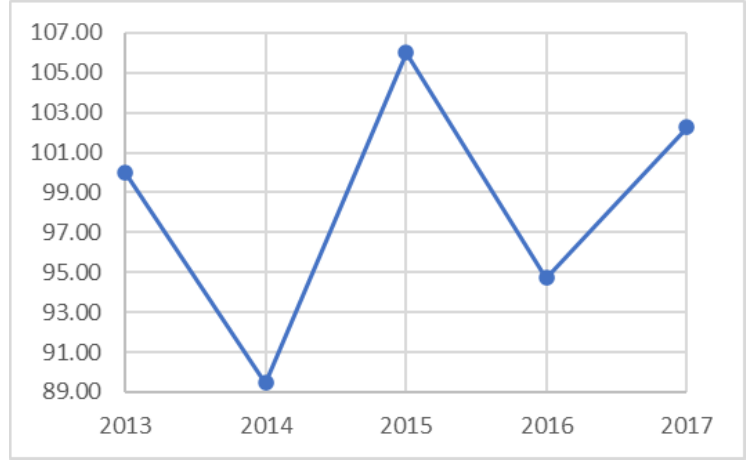
Figure 13. GDP growth in percentage w.r.t. to the 2013 value.